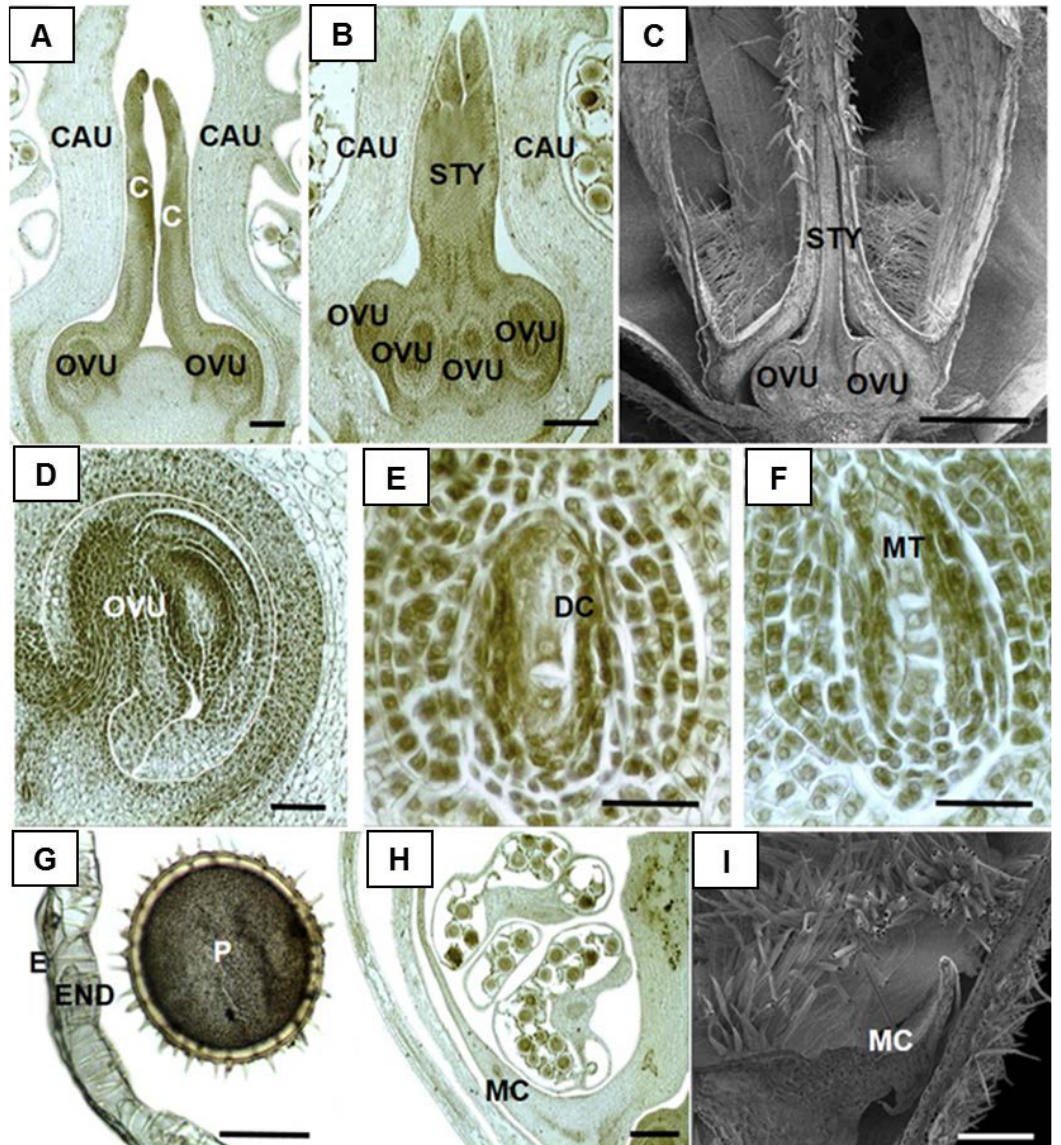
Fig. 7. Stage 10: Style formation. A. Growing and approaching to each other of carpel primordia. B. Single and thick style formation. C. SEM analysis of single and thick style. D. Anatropous ovule. E. Dyad cells. F. Linear megaspore tetrad. G. Very thin epidermis, wall tickenings in the endothecium and a mature pollen. H. Mature corolla in bowl appearance. I. SEM analysis of thin, sharp mature corolla. C: Carpel primordium, CAU: Corolla/androecium units, DC: Diad cells, E: Epidermis, END: Endothecium, MC: Mature corolla, MT: Megaspor tetrad, OVU: Ovule, P: Pollen, STY: Style. Bar: 5 µm (G, E, F), 10 µm (A, D), 20 µm (B, H), 200 µm (I), 1 mm